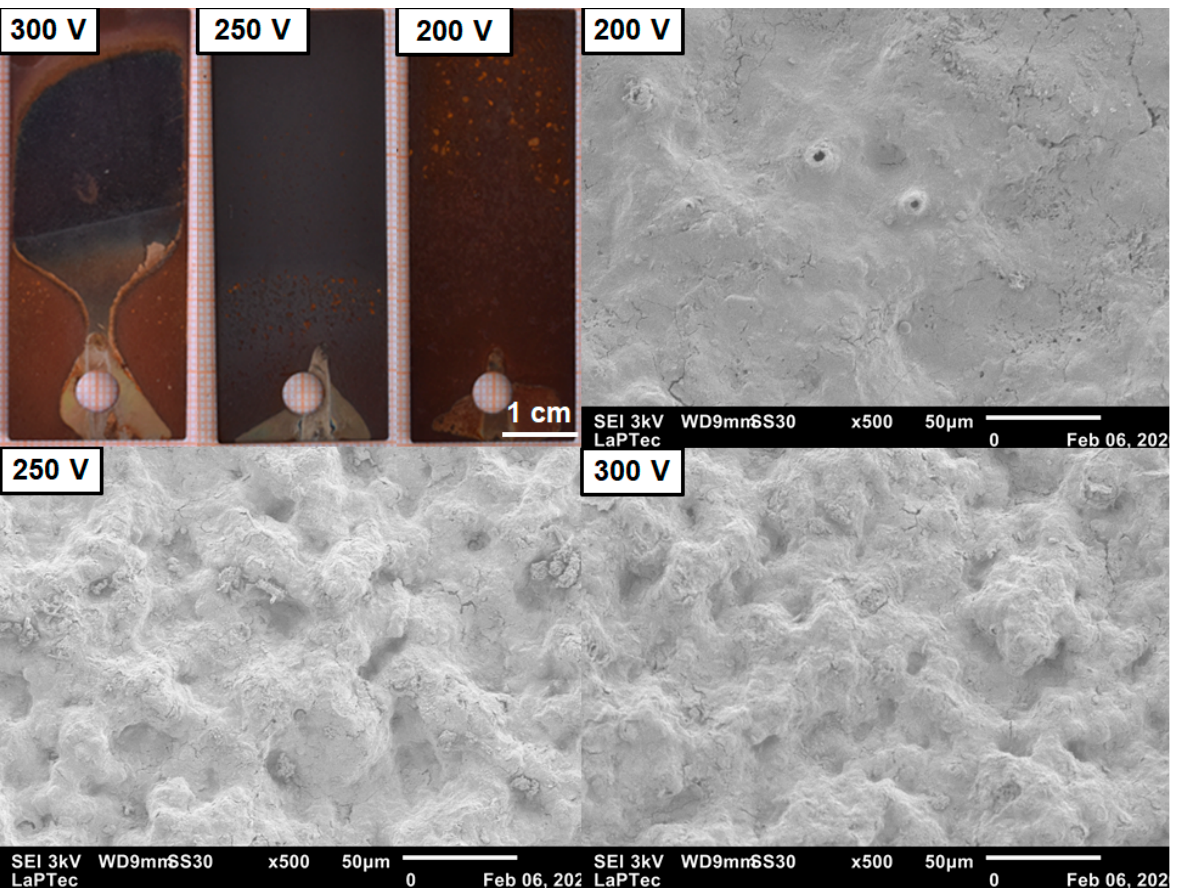
Figure 2. General view and surface topography of the PEO-treated samples. Table 1. Semi-quantitative EDS chemical analysis ( ± 0.1) of the selected elements on the surface.